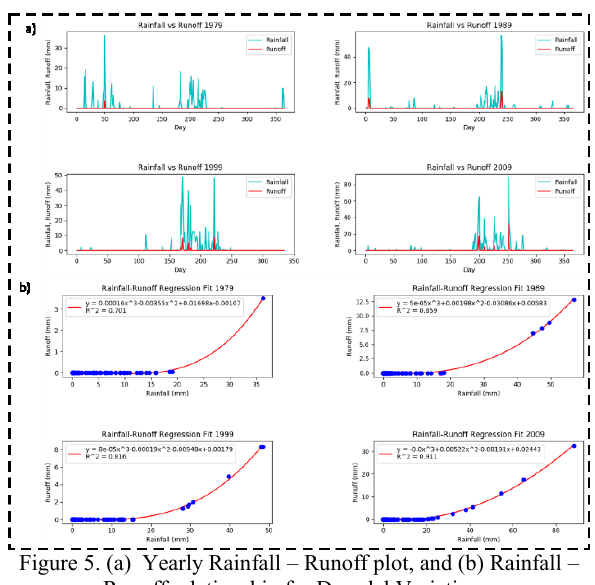
Figure 5. (a) Yearly Rainfall – Runoff plot, and (b) Rainfall – Runoff relationship for Decadal Variations.